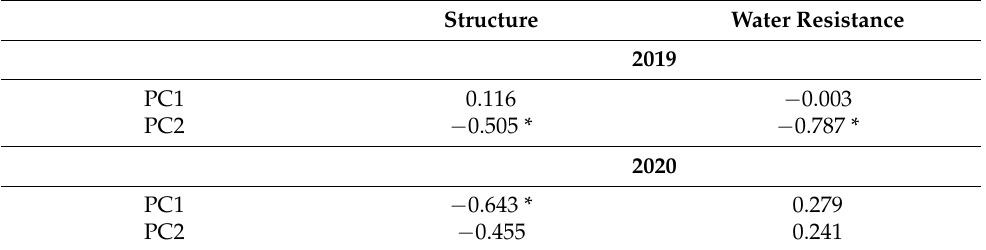
Table 10. The correlations between principal components from microbial community analysis and soil structural